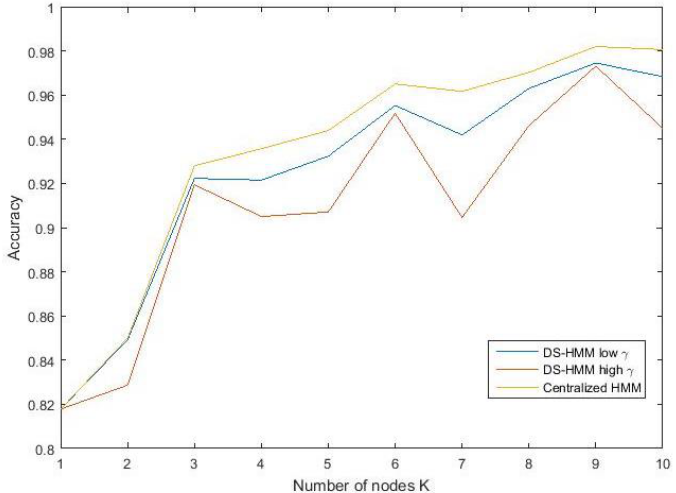
Figure 8. Accuracy as a function of the number of collaborating nodes. The distributed HMM (DS-HMM) solution is compared against a centralized HMM architecture.